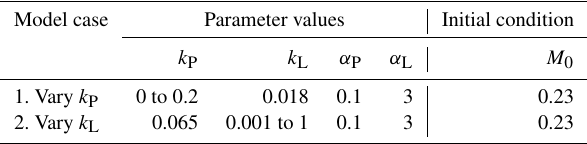
Table 4. Parameter values and initial conditions used for the model cases. Descriptions and units are listed in Table 2. The M 0 value is based on the mean IEPOX-SOA factor loading that was measured from 14:00 to 16:00UTC (10:00–12:00 local time) at a regional background site during 2 months of the wet season in 2008 (Chen et al., 2015). For comparison, a similar value of 0.19µgm − 3 was observed during the present study as the mean at the T3 site for NO y < 1ppb